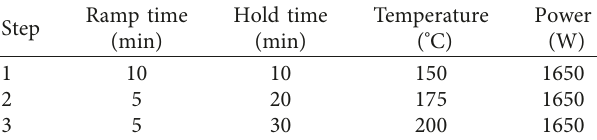
Table 3: Instrument parameter of microwave